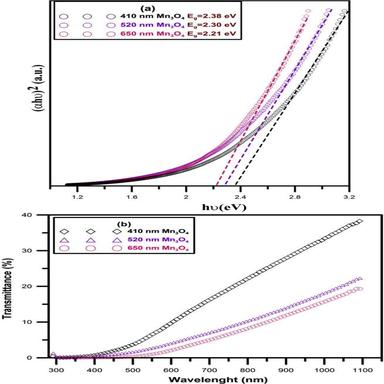
Optical characterization of the Mn3O4 films: (a) Plots of (hv) 2 vs. hv. (b) transmittance spectra of the Mn3O4 films for different thicknesses. Optical bandgap and transmittance decreases with increasing film thickness.